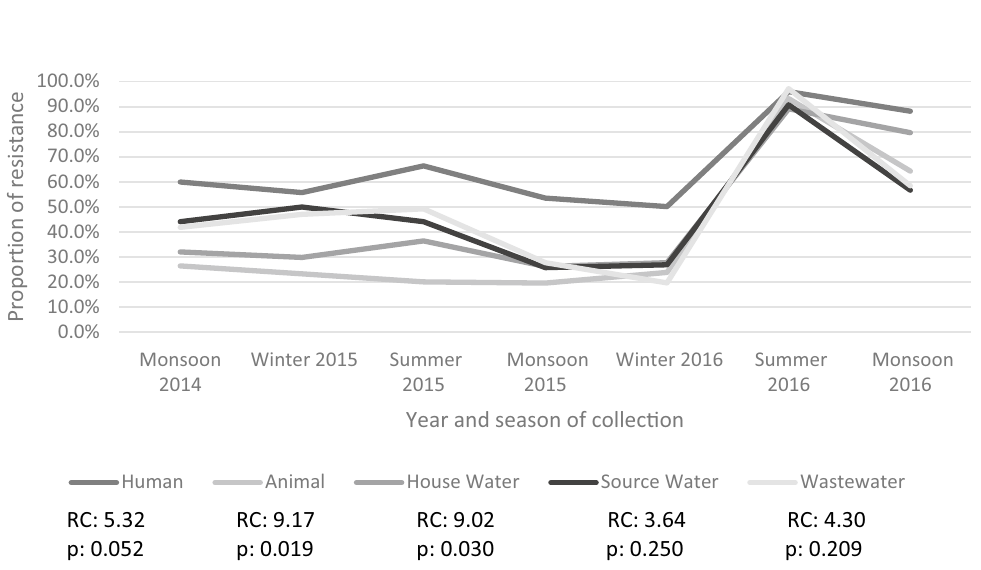
Table 2. Temporal trends of antibiotic resistance detected in humans, animals, household drinking water, source drinking water and wastewater, for each antibiotic. ESBL extended spectrum beta lactamase, MDR multi drug resistant. Bold text indicates statistical significance (p-value <0.05).